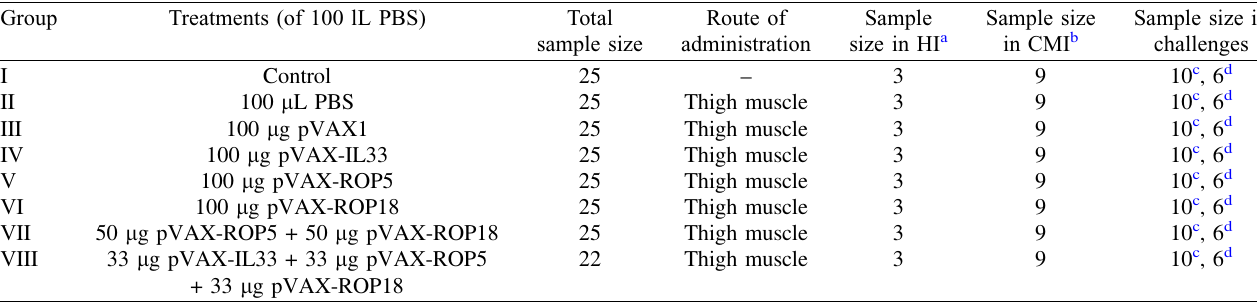
Table 1. Summary of treatments performed in study